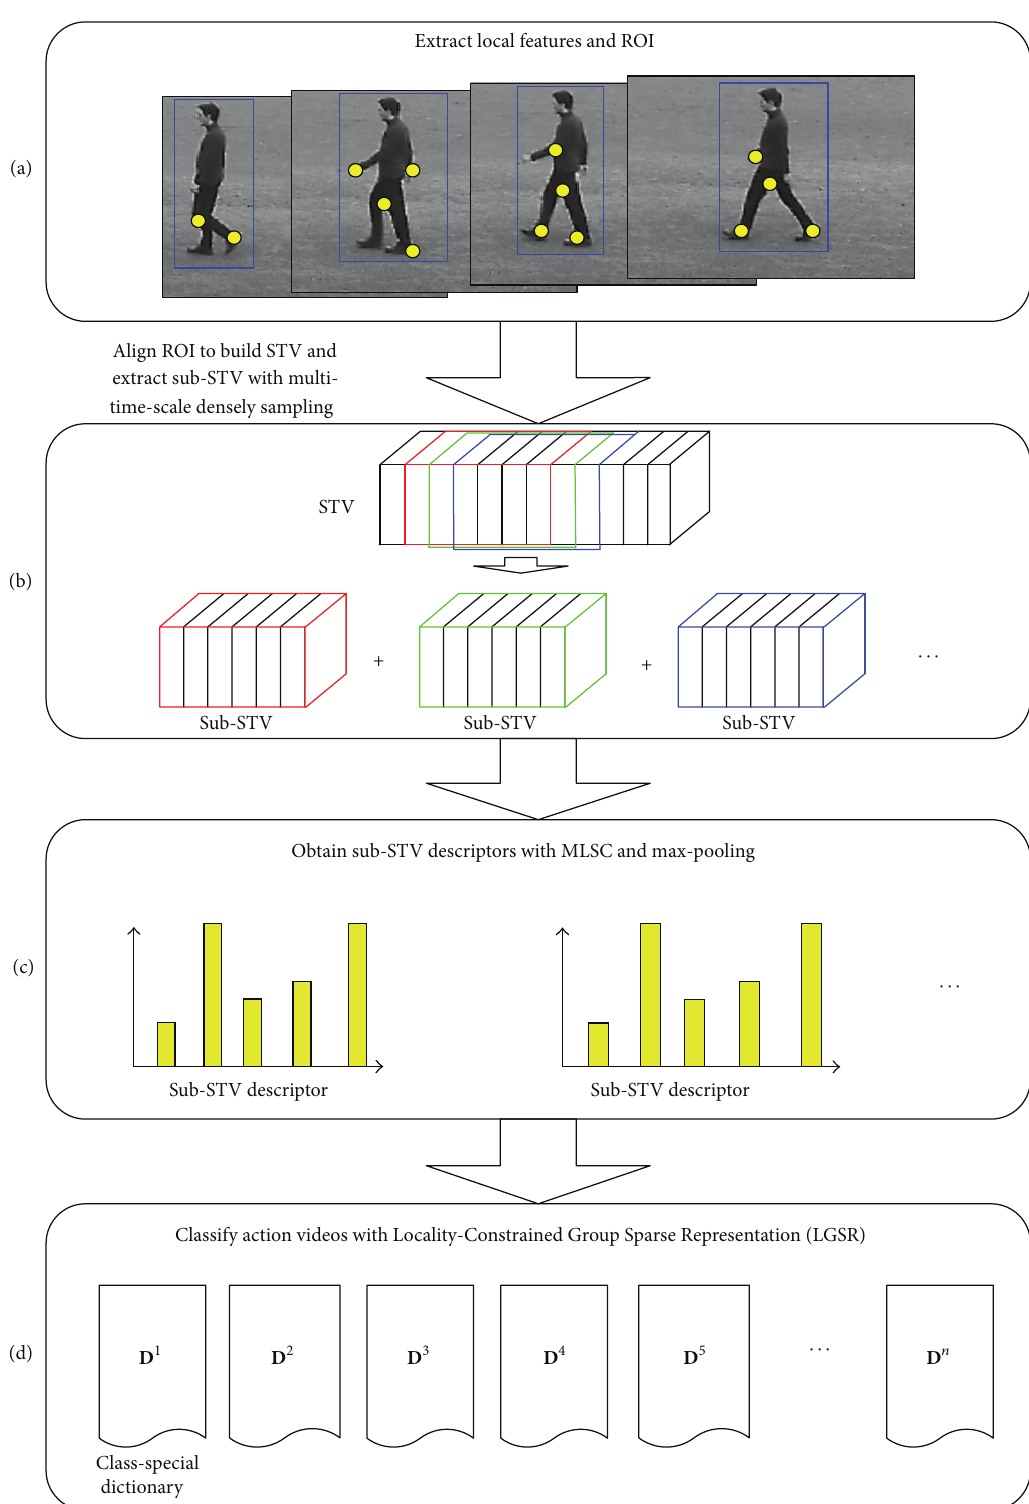
Figure 3: The flow chart of human action recognition with MLSC and